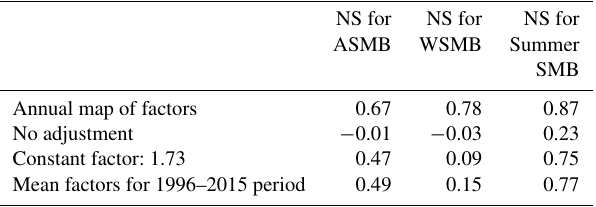
Table 3. NS efficiency coefficients for simulated surface mass bal- ances with respect to measured values over the 2006–2010 period. Simulations were performed using three different approaches to cor- rect precipitation and were evaluated for the winter SMB, summer SMB and annual SMB.